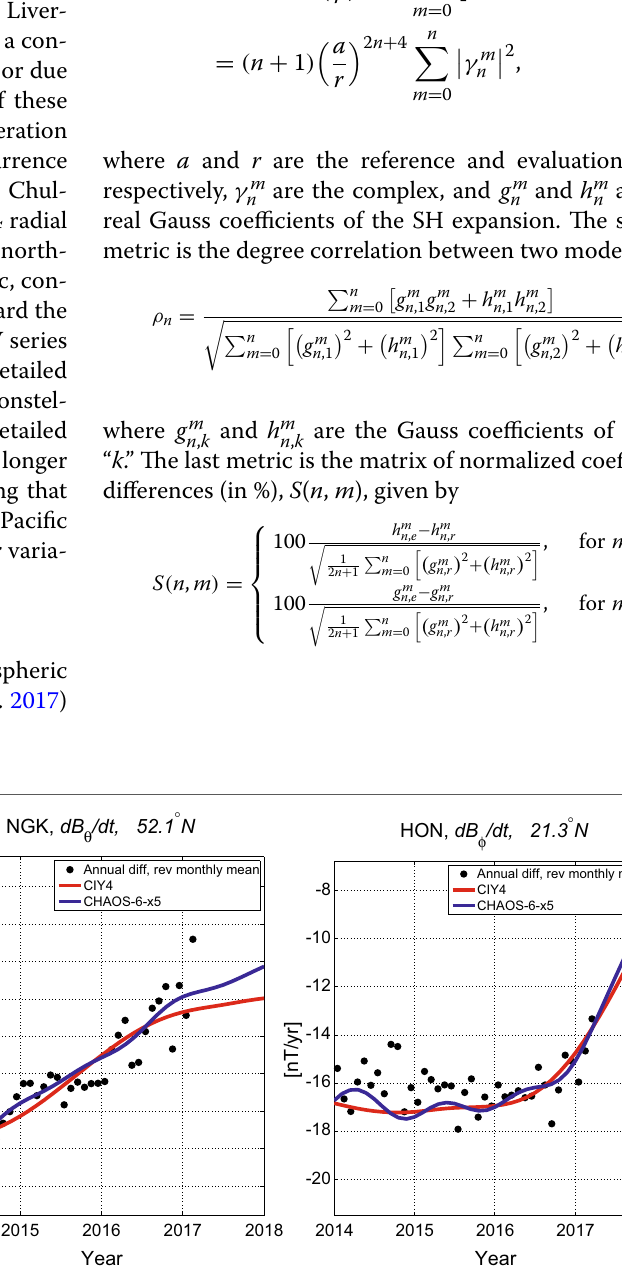
Fig. 5 Comparison of CIY4 (red) and CHAOS‑6‑x5 (blue) fits to ground observatory SV data (annual differences of revised monthly means) in the ˙ B r , ˙ B ˙ B φ components of GUA, NGK, and HON, θ , and